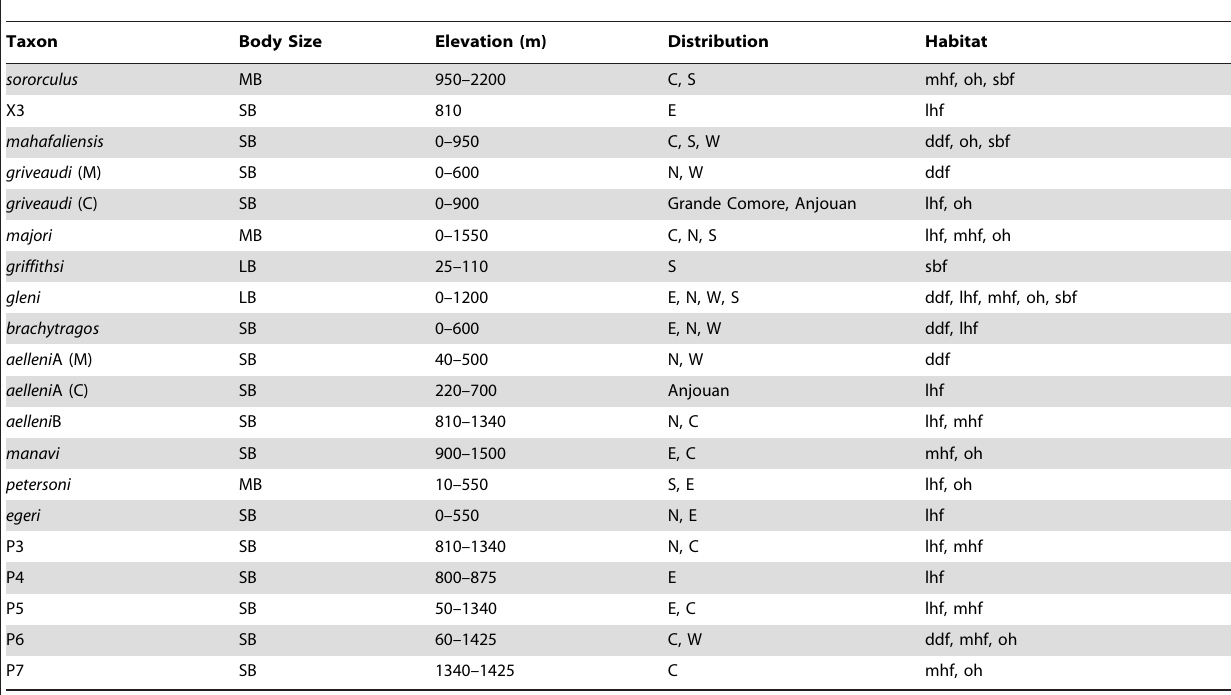
Table 3. Summary of different size and life-history parameters of Malagasy (M) and Comorian (C) Miniopterus spp.